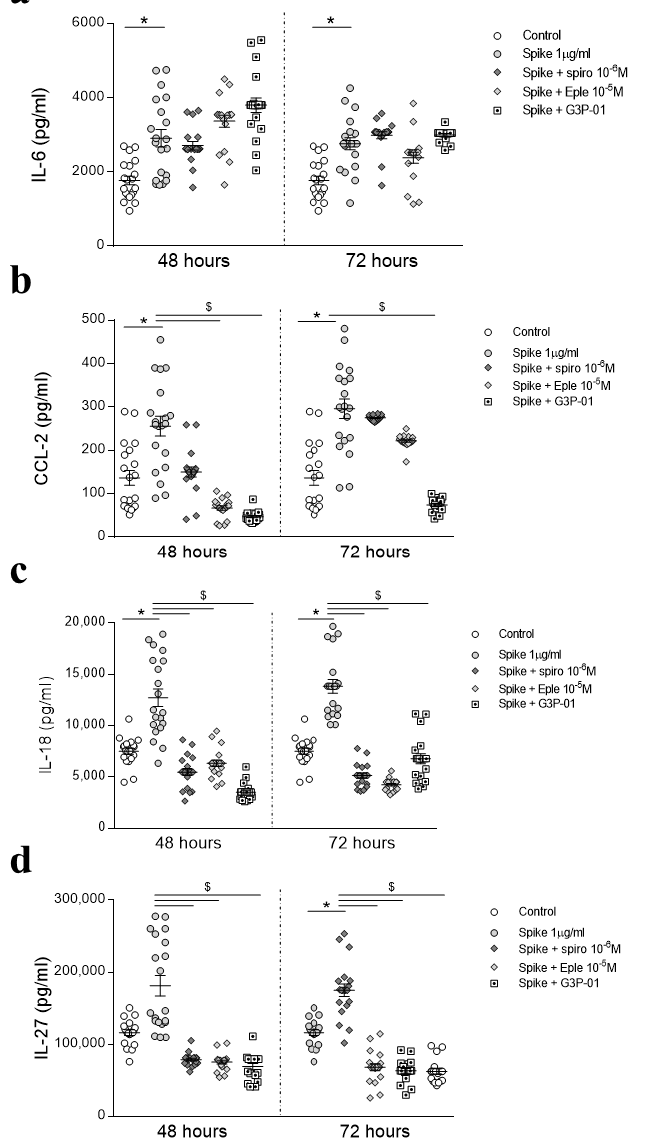
Figure 5. Protective effects of MR pathway blockade after 24 h-Spike protein treatment in HAECs. The secretion of proinflammatory cytokines was evaluated in HAECs treated with recombinant Spike protein for 24 h and then with Spironolactone, Eplerenone, or G3P-01 for 48 or 72 h. IL-6 ( a ), CCL-2 ( b ), IL-18 ( c ), IL-27 ( d ). Control, n = 20; Spike, n = 20; Spike + Spiro, n = 20; Spike + Eple, n = 20; Spike + G3P-01, n = 20. Results were analyzed using one-way-ANOVA followed by Dunnet’s post-hoc multiple comparisons tests. * vs. control; $ vs.